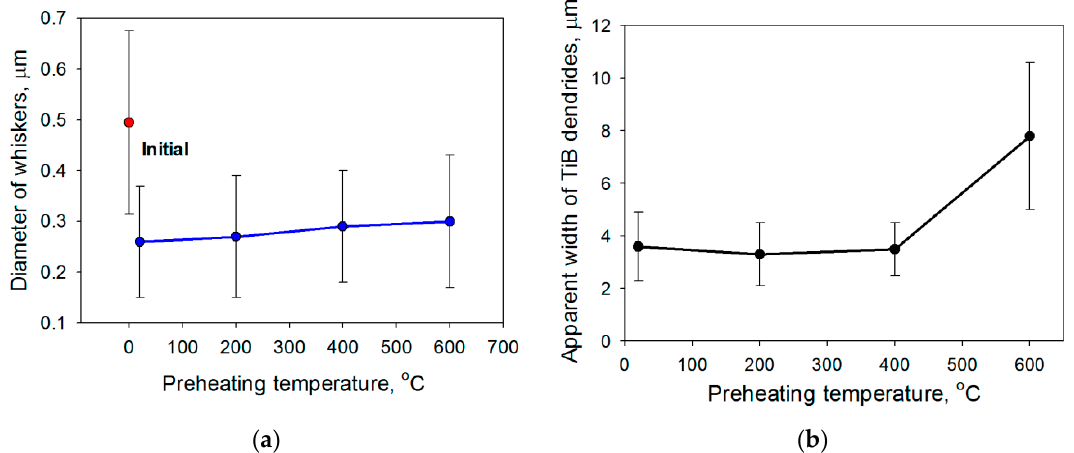
Figure 6. Average diameter of individual TiB whiskers ( a ) and apparent width of TiB dendrites ( b ) in the weld zone as a function of pre-heating temperature.